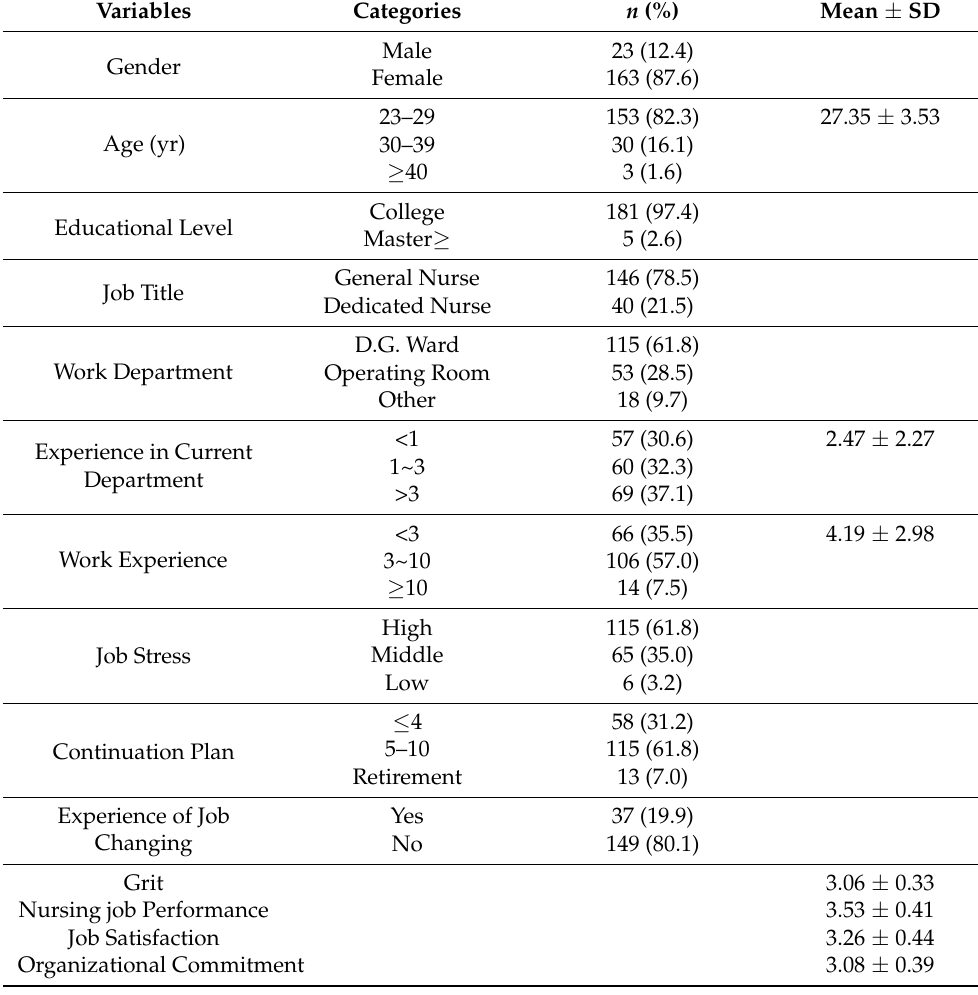
Table 1. Participants’ characteristics and study variables (N =